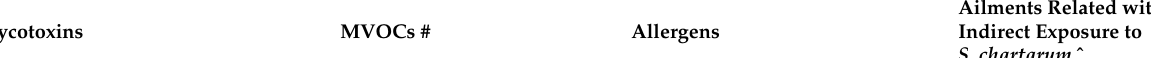
Table 2. Negative aspects related to the presence of S. chartarum in homes and dwellings *.